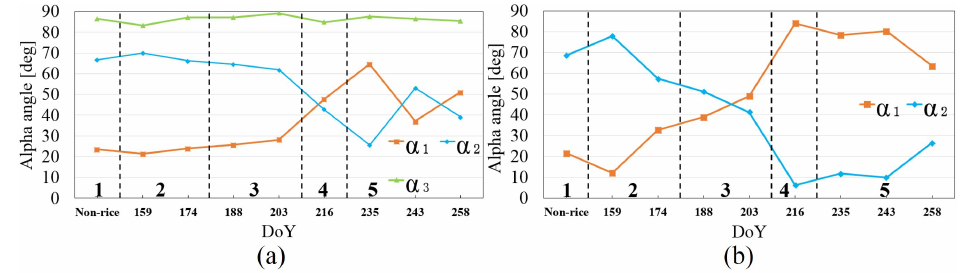
Figure 9. Alpha angle corresponding to each eigenvector. ( a ) FCP mode; ( b ) DCP mode.